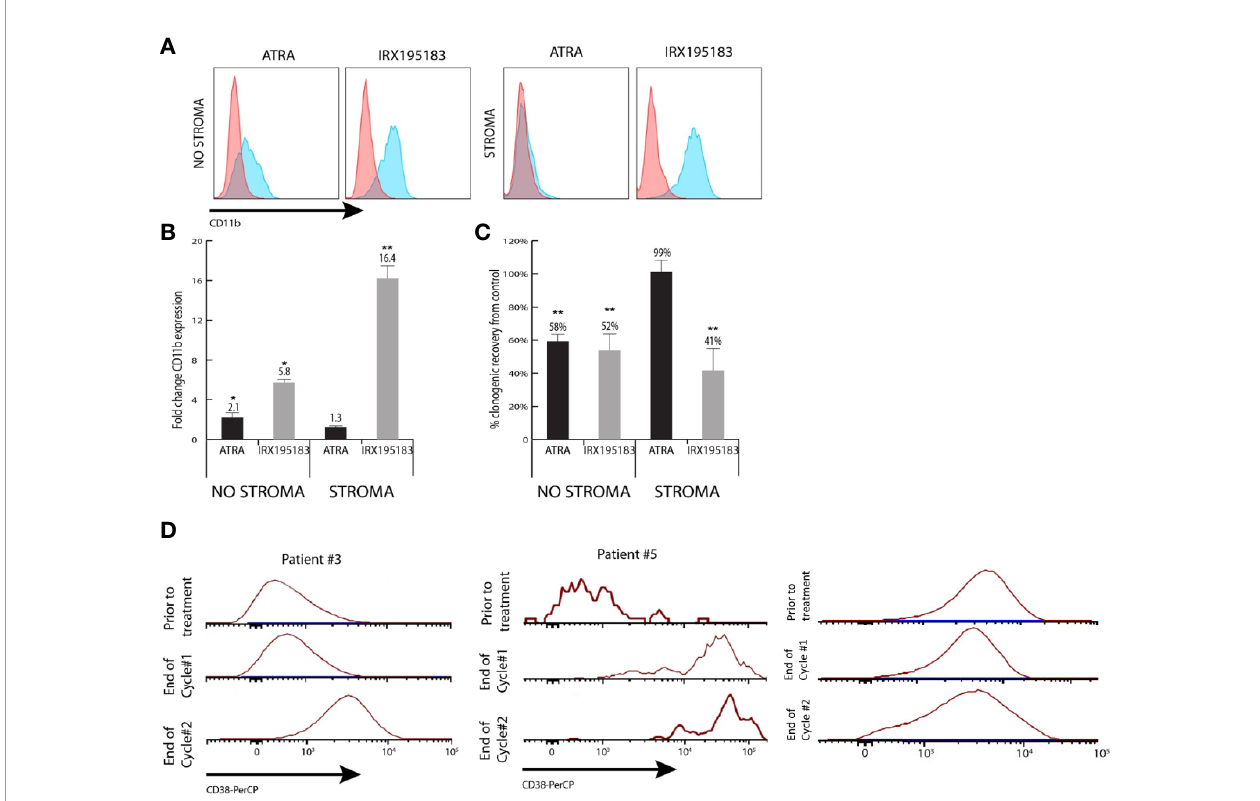
FIGURE 3 | Differentiation activity of plasma from patients treated with IRX195183. (A) Representative fl ow plots of CD11b expression of NB4 cells cultured in the presence of 10% plasma from patients treated with ATRA (1 st and 3 rd ) or IRX195183 (2 nd and 4 th ) in the presence or absence of bone marrow stroma. (B, C) Differentiation activity on plasma from patients treated with either ATRA or IRX195183 as measured by upregulation of CD11b expression (B) and decreased clonogenic activity (C) of NB4 cells. Data represents mean ± SEM, n = 4 independent patients, *p < 0.05, **p < 0.01. P was calculated using unpaired, 2-tailed Student ’ s t test. (D) CD38 expression on the leukemic blasts from patient #3 and patient #5 treated with